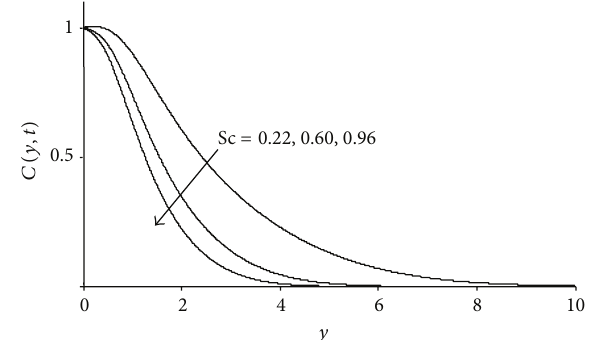
Figure 7: Velocity profiles for Pr eff = 0 . 350 ( 𝑁 𝑟 = 1, Pr = 0 . 7), = 0 . 7, 𝑡 = 1 . 2, and different values of constant shear stress 𝑓 . 𝐾 𝑝